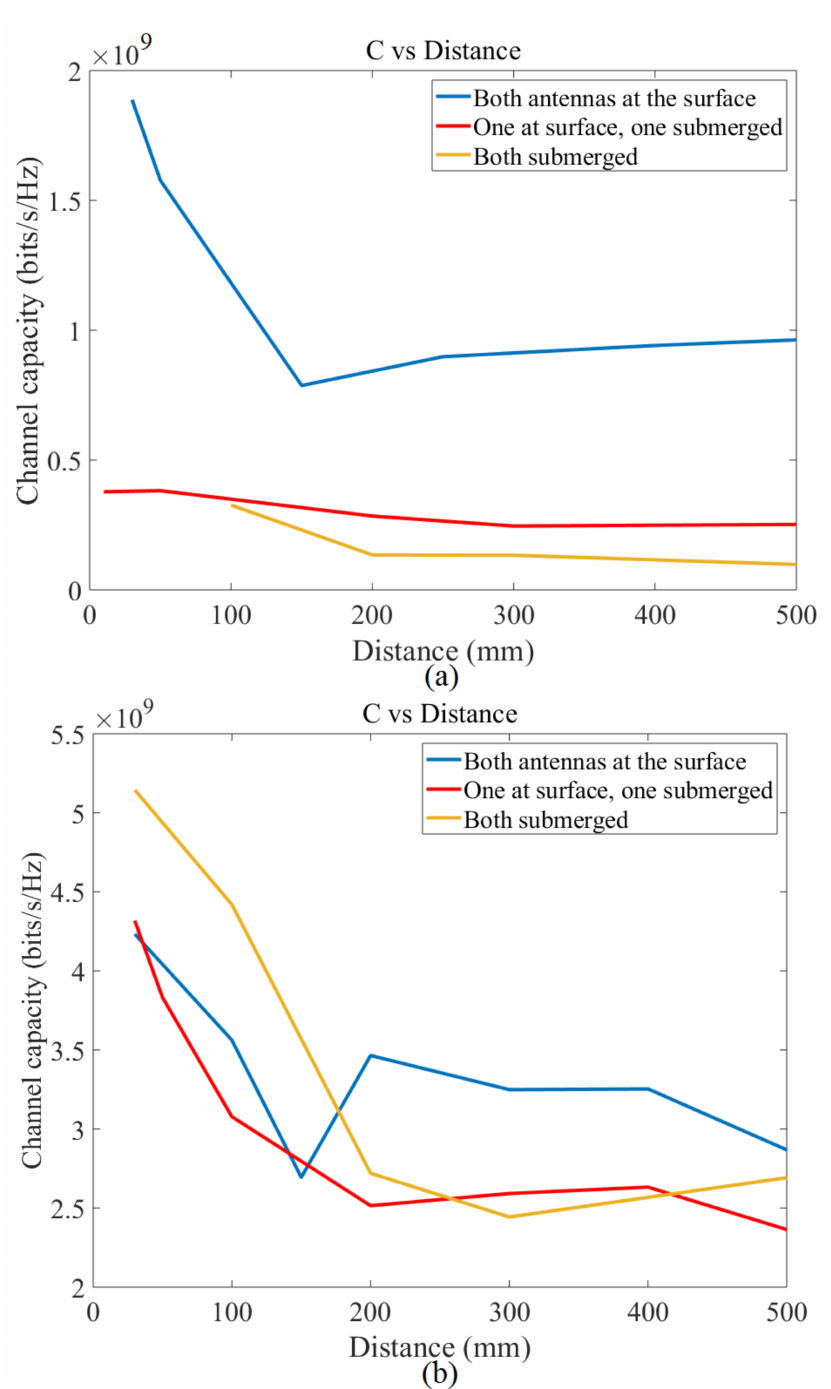
Figure 16. Channel capacity in terms of the distance between the antennas with a maximum band- width (BW) ( a ): fresh water and ( b ): sea